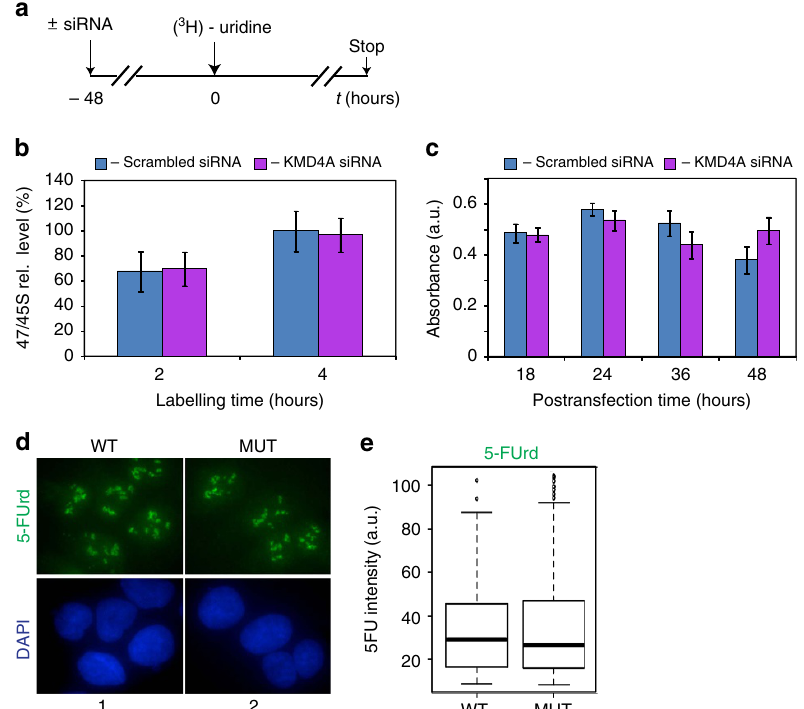
Figure 2 | KDM4A is not essential for ongoing Pol-I transcription. ( a ) Schematic representation of the labelling of cells with 3 H-uridine to determine the effect of KDM4A depletion on ongoing rRNA synthesis. RNA was extracted 2 and 4h after 3 H-uridine addition and de nov o rRNA transcripts were detected by tritium imaging of RNA blots as in Fig. 3b. ( b ) The relative efficiencies of rRNA synthesis were quantitated as in Fig. 3 and transcript levels are indicated for 47S/45S pre-rRNA. The data, expressed as a percentage of the highest value (set at 100%). The s.d.’s for three independent experiments are shown; n ¼ 3. ( c ) The relative efficiencies of cell growth were determined using MTTassay. The s.d.’s for four independent samples are shown; n ¼ 4. ( d ) Growing U2OS cells ( B 70% confluent) were electroporated with an expression vector encoding either wild-type KDM4A (WT) or catalytically inactive mutant (MUT). Cells were grown for 48h and then 5-FUrd was added for 30min and cells were fixed and analysed by indirect immunofluorescence using antibodies specific to 5-FUrd (anti-BrdU antibodies); nuclear DNA was stained by DAPI. ( e ) Box-and-whiskers plot of the quantification of 5-FUrd staining per cell ( n ¼ 100–200) obtained from the experiment shown in d using R open source software (a.u. stands for arbitrary units). Note that the 5-FUrd levels of the cell populations overexpressing the MUTand the WTare not significantly different ( P value ¼ 0.637, Wilcoxon test). The median values are shown as horizontal lines, outliers are shown as open circles; n ¼